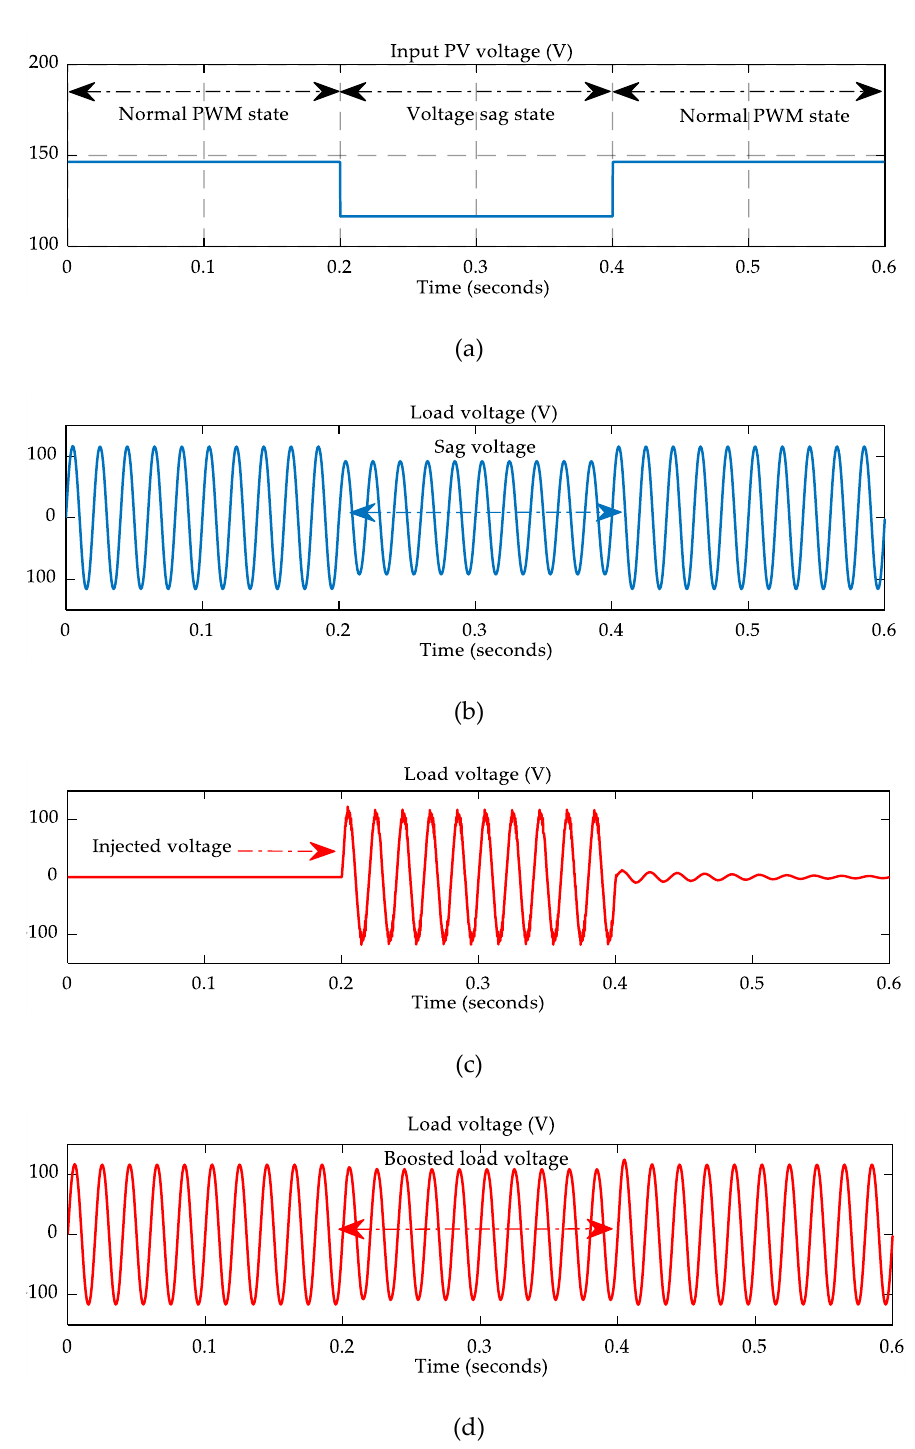
Figure 9. Simulation results: ( a ) output voltage of the PV unit, ( b ) sagged load voltage, ( c ) injected shoot-through voltage to load, and ( d ) output boosted load voltage.